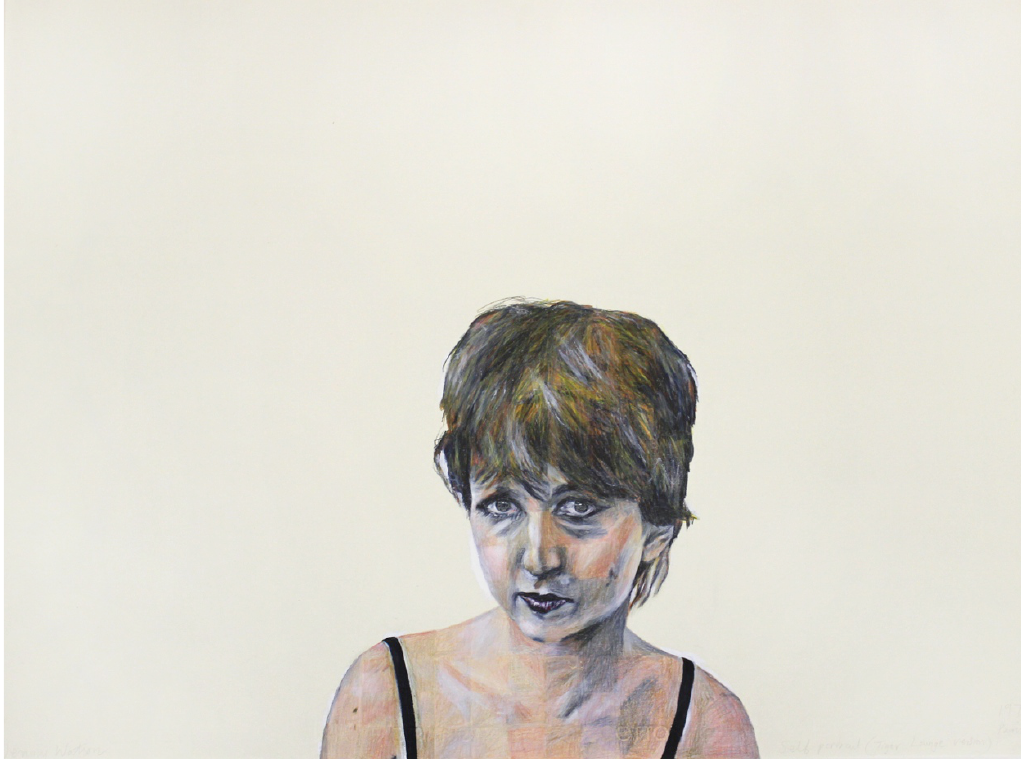
Jenny Watson, Self Portrait: Tiger Lounge Version , 1979, gouache and pencil on paper, 56.2 x